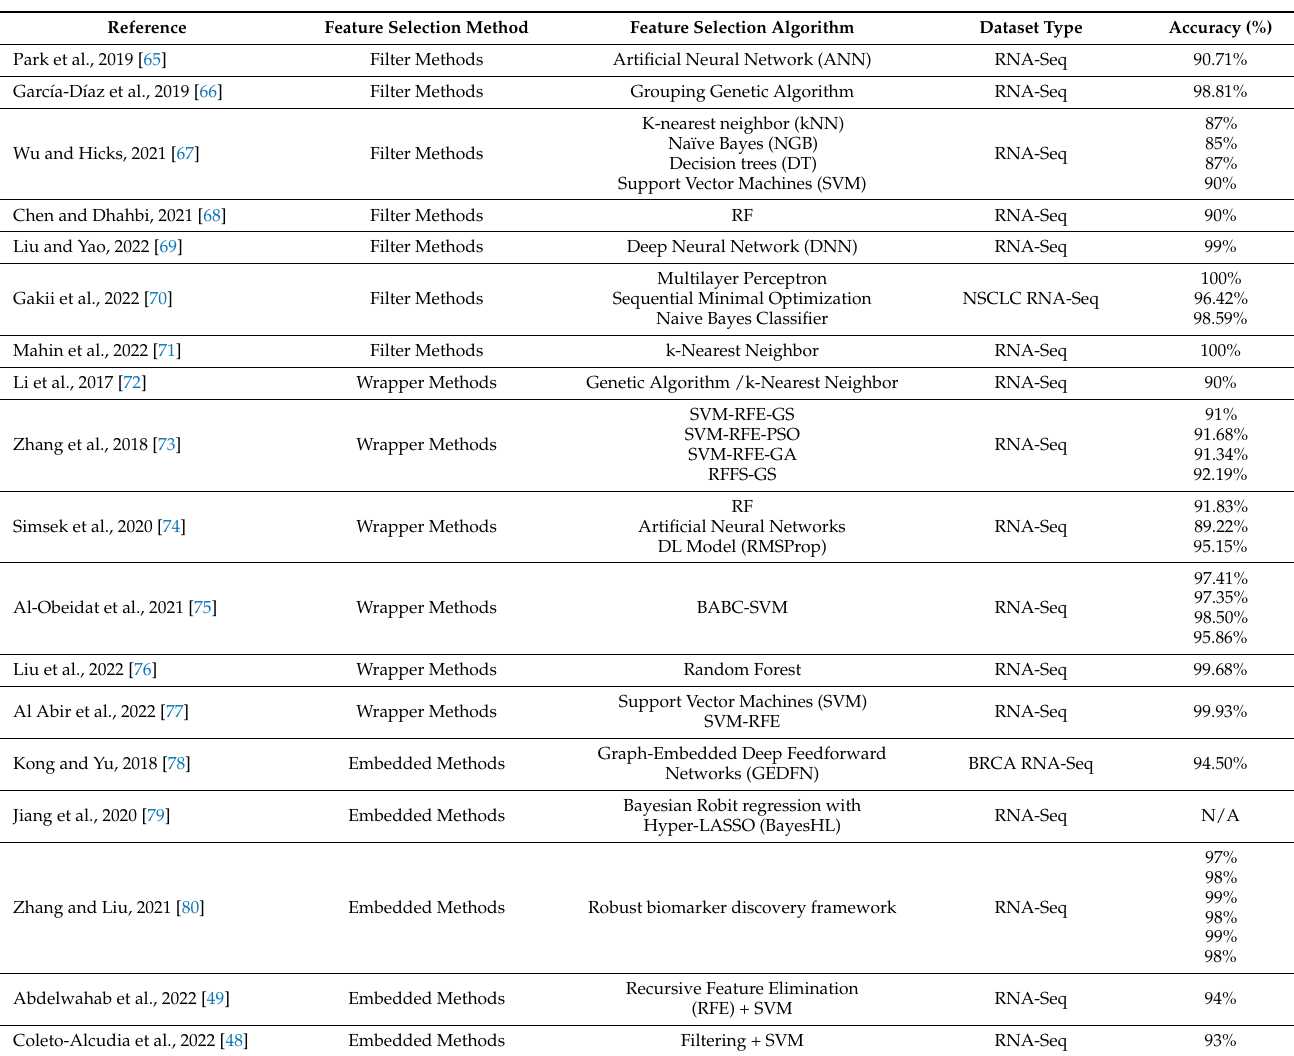
Table 4. Feature selection methods in gene expression